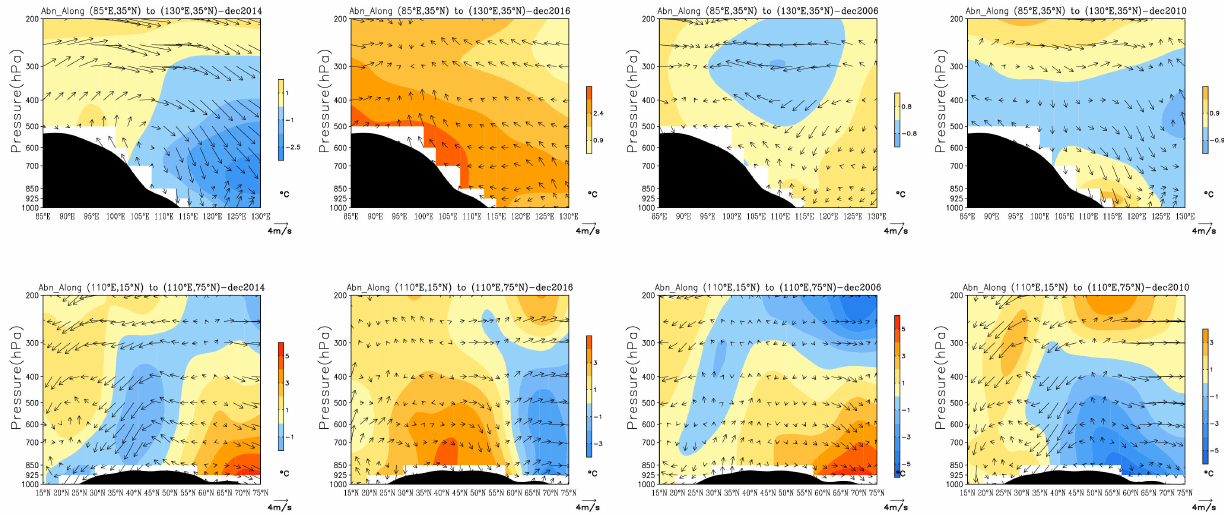
Figure 12. Cross sections of the east − west ( top ) and north − south ( bottom ) circulations and the temperature in strong Q 1 − strong EAWMI year (first from left), weak Q 1 − weak EAWMI year (second from left), strong Q 1 − weak EAWMI year (third from left) and weak Q 1 − strong EAWMI year (fourth from left) in the Fen − wei Plain